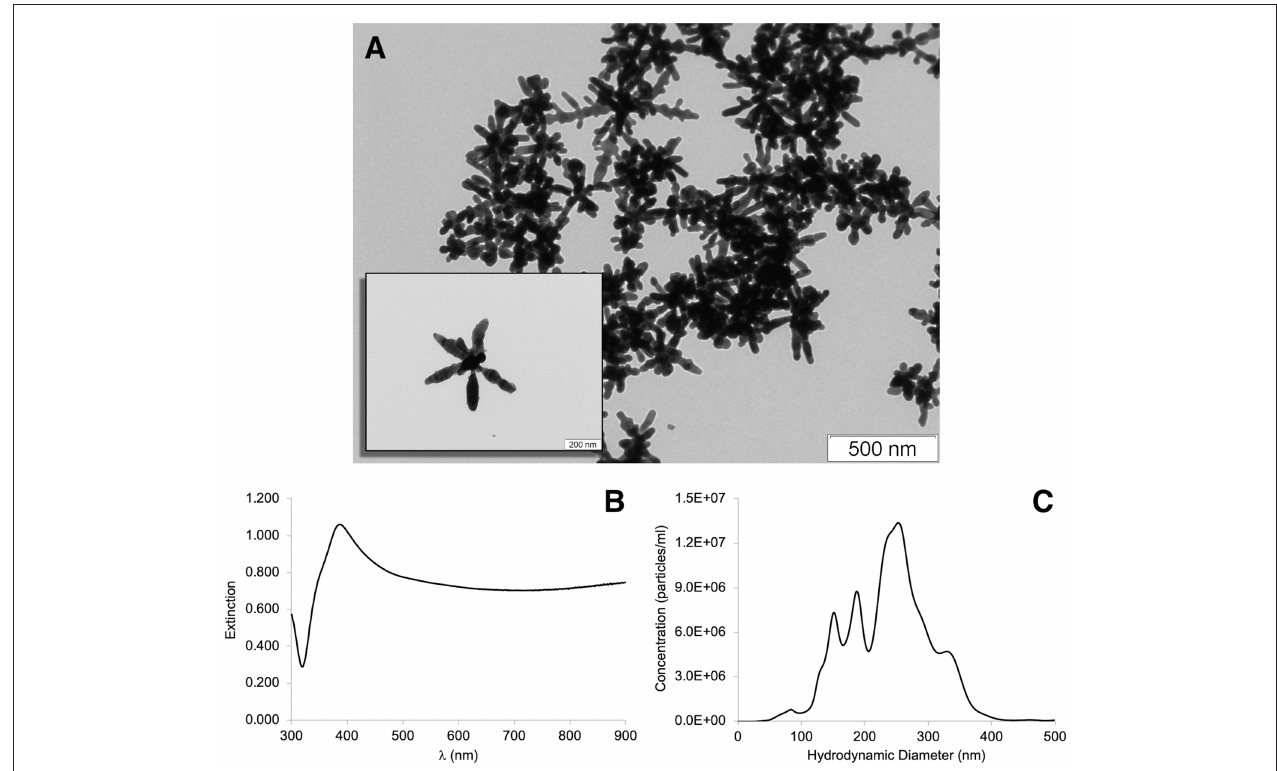
FIGURE 2 | Silver nanostars (AgNS) colloid characterization by (A) Transmission Electron Microscopy (TEM) micrographs; (B) UV-visible spectrum, and (C) hydrodynamic diameter distribution, obtained by Nanoparticle Tracking Analysis (NTA).